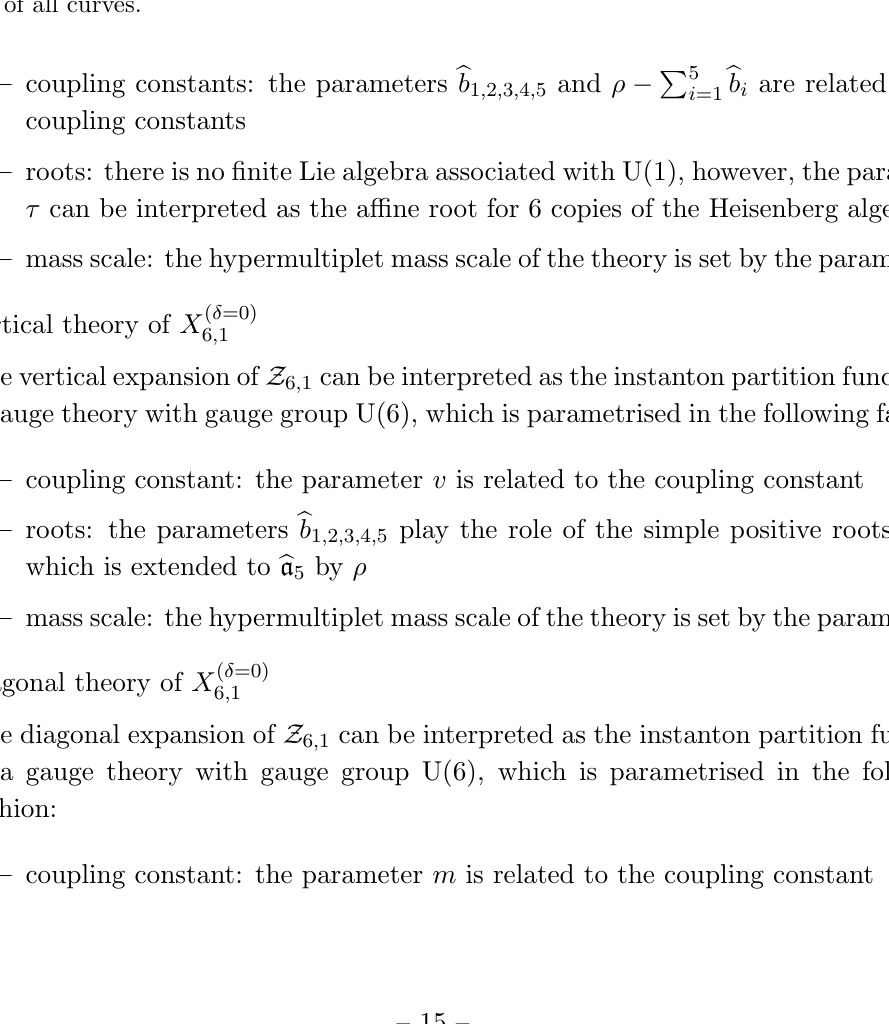
Figure 8 . Toric web diagram of X 6 ; 1 (with shift parameter (cid:14) = 0) with a consistent labelling of the areas of all